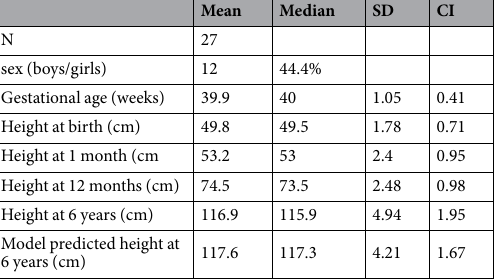
Table 2. Height data of a subset of the BILD cohort and model predictions. Definitions are given in Table 1. There is no statistically significant difference between measured and model predicted height at 6 years (paired t-test).